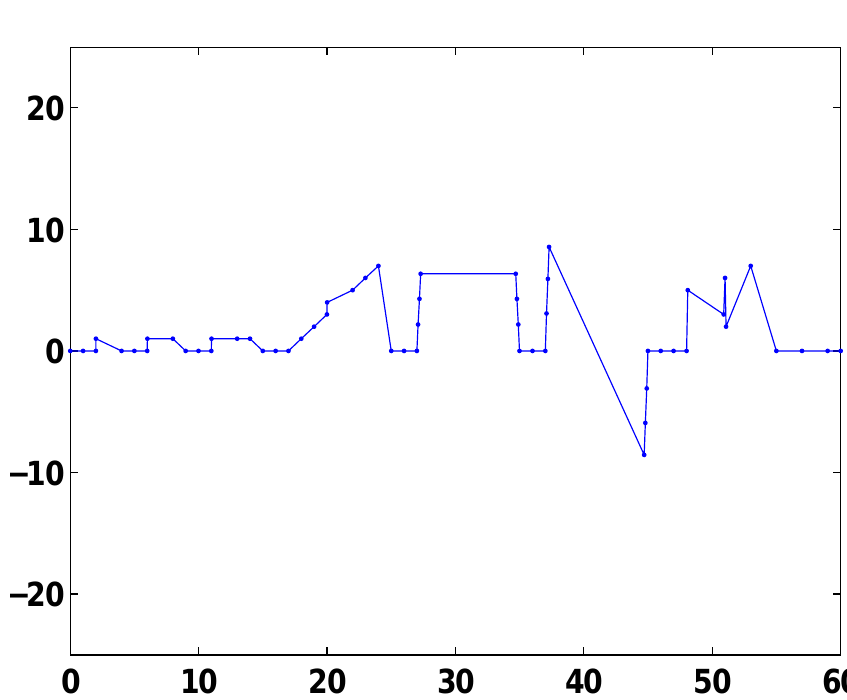
Figure 1 . Data set and linear